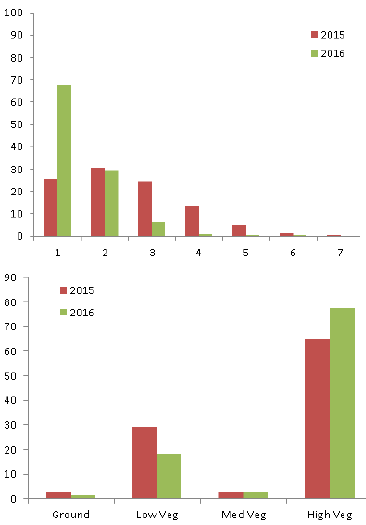
Figure 3. Distribution of lidar returns in various point classes (top) and multi-targets (bottom)